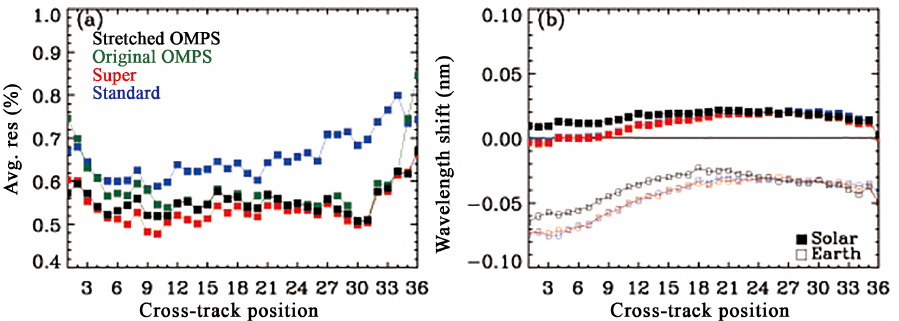
Figure 4. Same as Fig. 2 but for (a) average fitting residuals (%) as a function of cross-track positions. The green line represents the fitting residuals with measured OMPS slit functions without fitting a scaling factor. (b) Wavelength shifts between OMPS irradiance and reference spectrum (filled symbols) and between OMPS radiance at the middle swath line and reference spectrum (opened symbols).